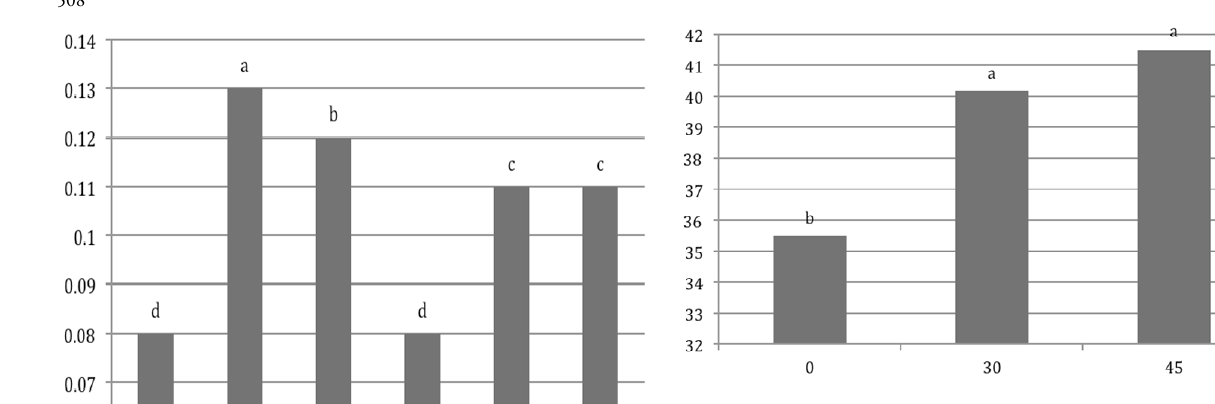
Fig. 2. Pulsed electromagnetic field impact on leaf area (mm 2 ) of two durum wheat varieties. Seeds have been treated for 0 (control), 30 and 45 minutes with magnetic field Means followed by the same letter for treatments are not significantly different according to the least significant difference (LSD) test.